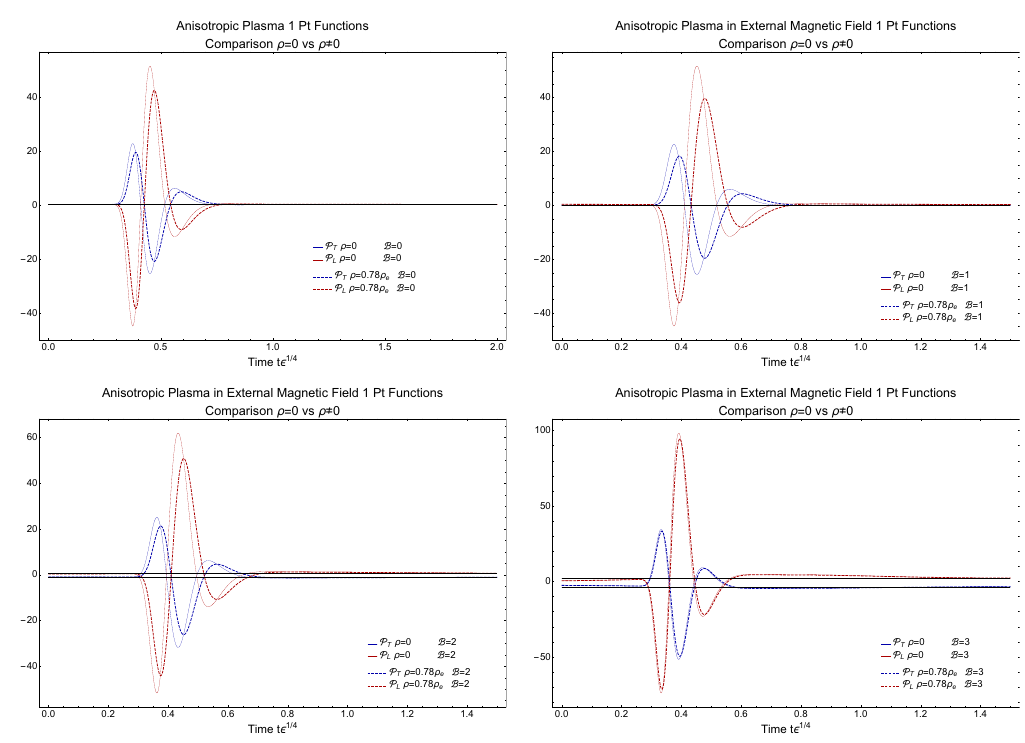
Figure 3 . Four plots are displayed, each showing the di(cid:11)erences in the 1-point functions P T and P L obtained during the isotropization process due to the inclusion of a non zero charge density (cid:26) = 0 : 78 (cid:26) e . Top left: no external magnetic (cid:12)eld. Top right: external magnetic (cid:12)eld B = 1. Bottom left: external magnetic B = 2. Bottom right: external magnetic B =